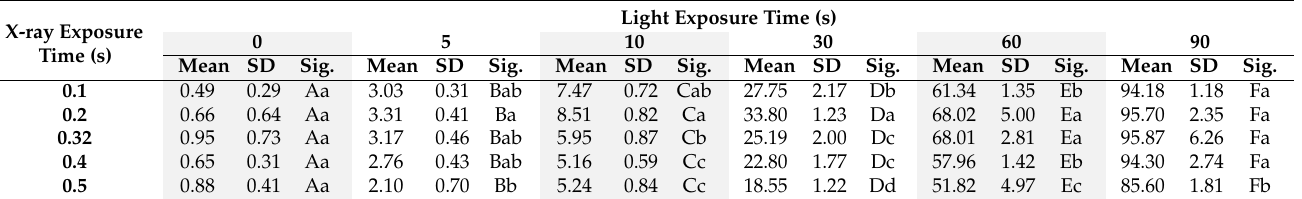
Figure 4. Bar graphs showing mean values of brightness and contrast discrepancies (in gray values) and standard deviations (error bars) as a function of exposure times of X-rays and ambient light for both digital radiographic systems. Table 2. Mean values, standard deviation (SD), and pairwise significance (Sig.) of brightness discrepancy as a function of light and X-ray exposure times for the VistaScan system.